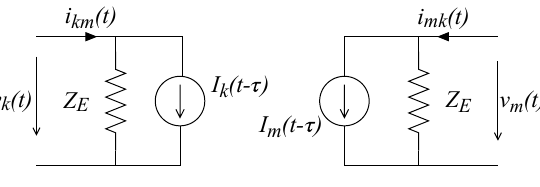
Figure 3. Equivalent circuit for a lossless